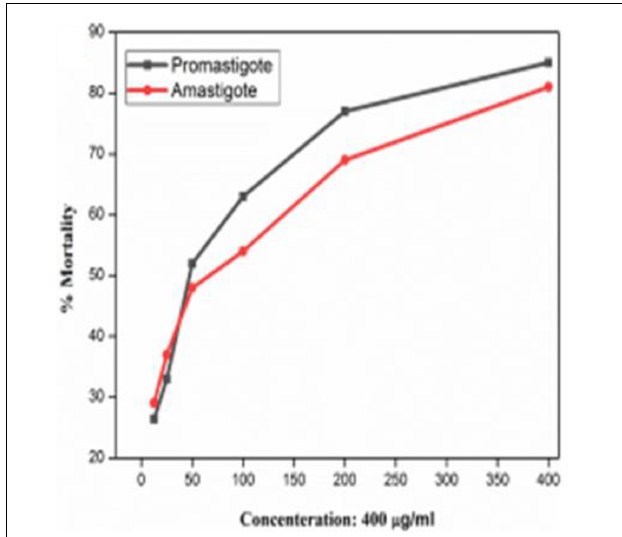
FIGURE 8 | Anti-leishmanial assay: Mortality (in %) of amastigote and promastigote parasites.